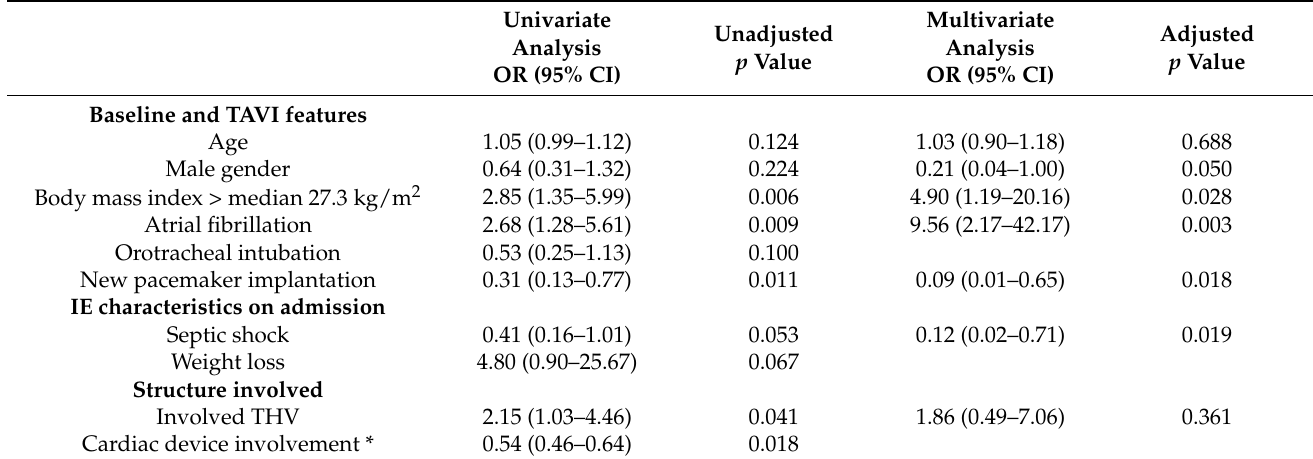
Table 3. Factors associated with Enterococcus as causative microorganism in patients with IE post-